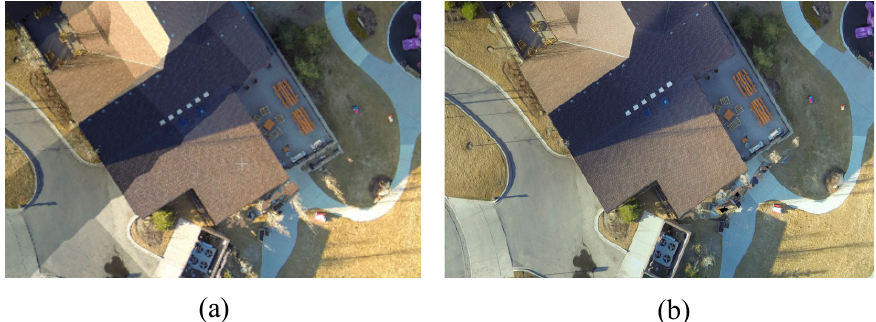
Figure 16. The generated RGB-based orthophoto mosaic from ( a ) the proposed automated aerial triangulation, and ( b ) Pix4D for Phantom2-Building Dataset.